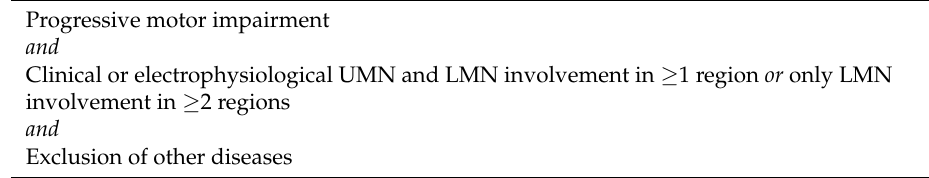
Table 2. The Gold Coast criteria